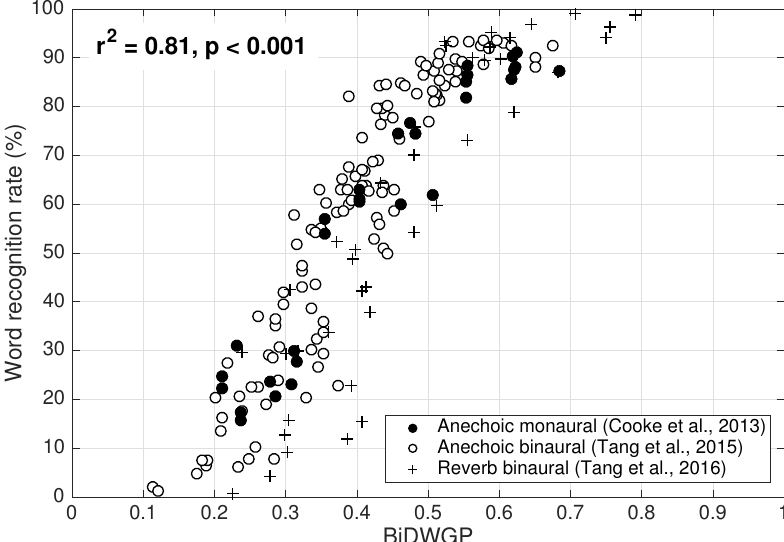
Figure 2. Scatter plot of listeners’ sentence-level word recognition scores against binaural distortion-weighted glimpse proportion (BiDWGP) predictions for monaural listening in anechoic conditions (30 solid circles), binaural listening in anechoic (120 open circles) and reverberant conditions (40 crosses). r 2 is also